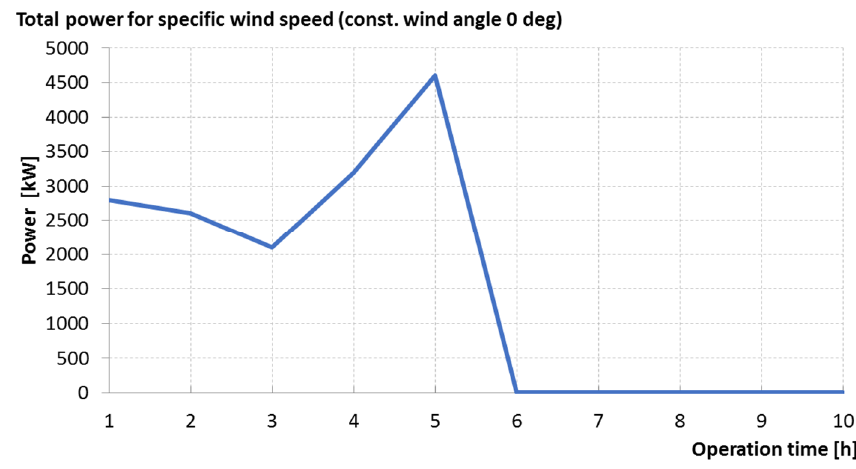
Figure 17. Power consumption during the positioning operation.